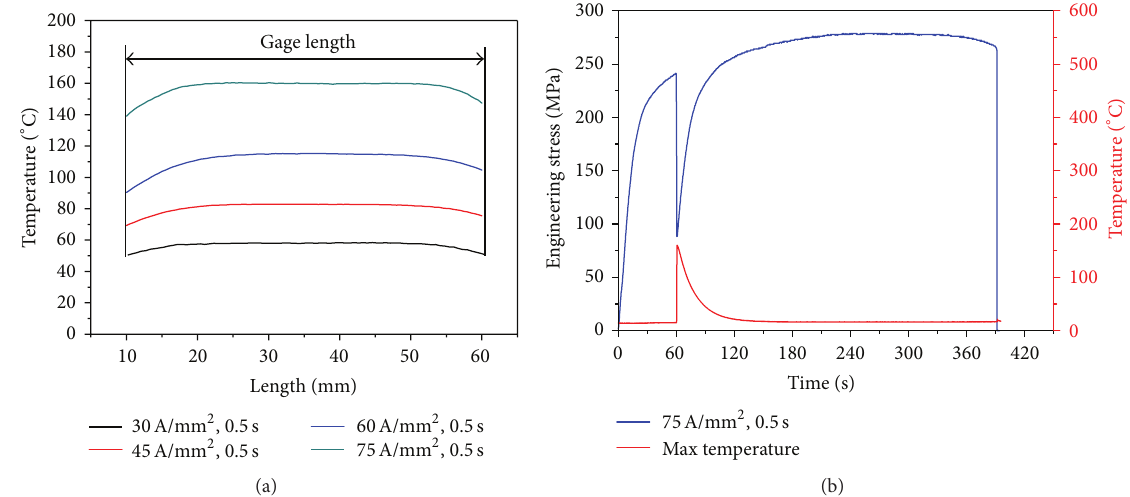
Figure 3: (a) Temperature profiles along the center-line of the gage of specimen and (b) a history of the maximum temperature within the gage of specimen during a tensile test with 𝜌 𝑖 𝑜 = 75 A/mm 2 , 𝑡 𝑑 = 0.5 sec.